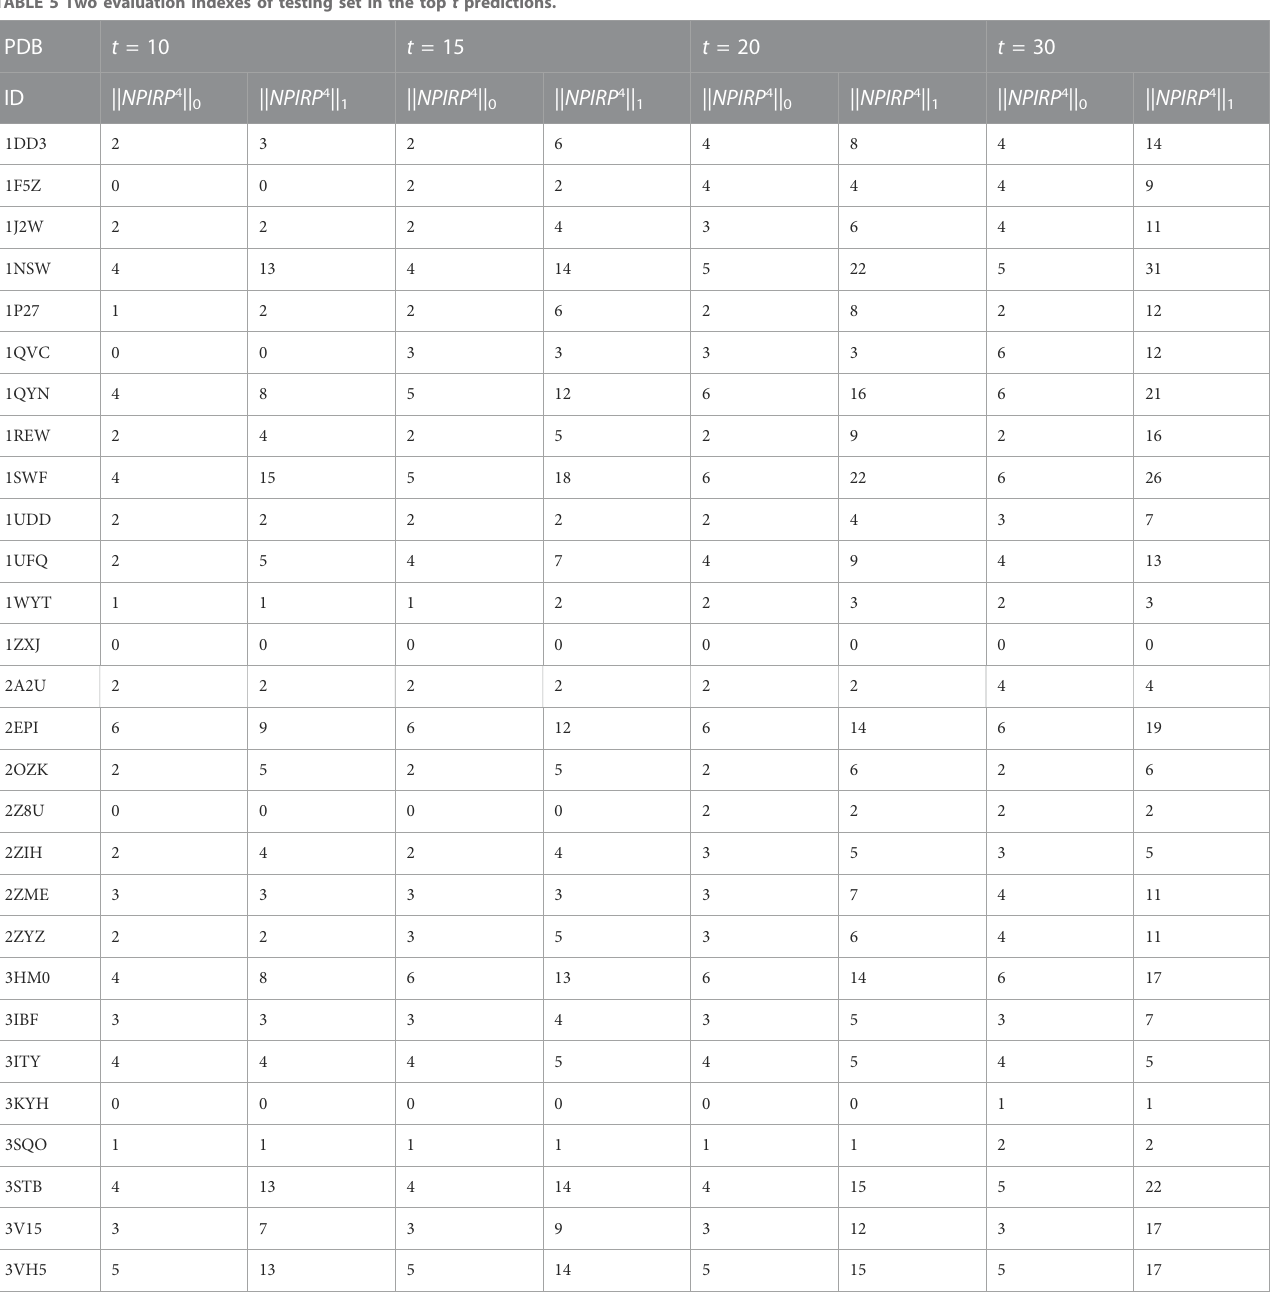
TABLE 5 Two evaluation indexes of testing set in the top t